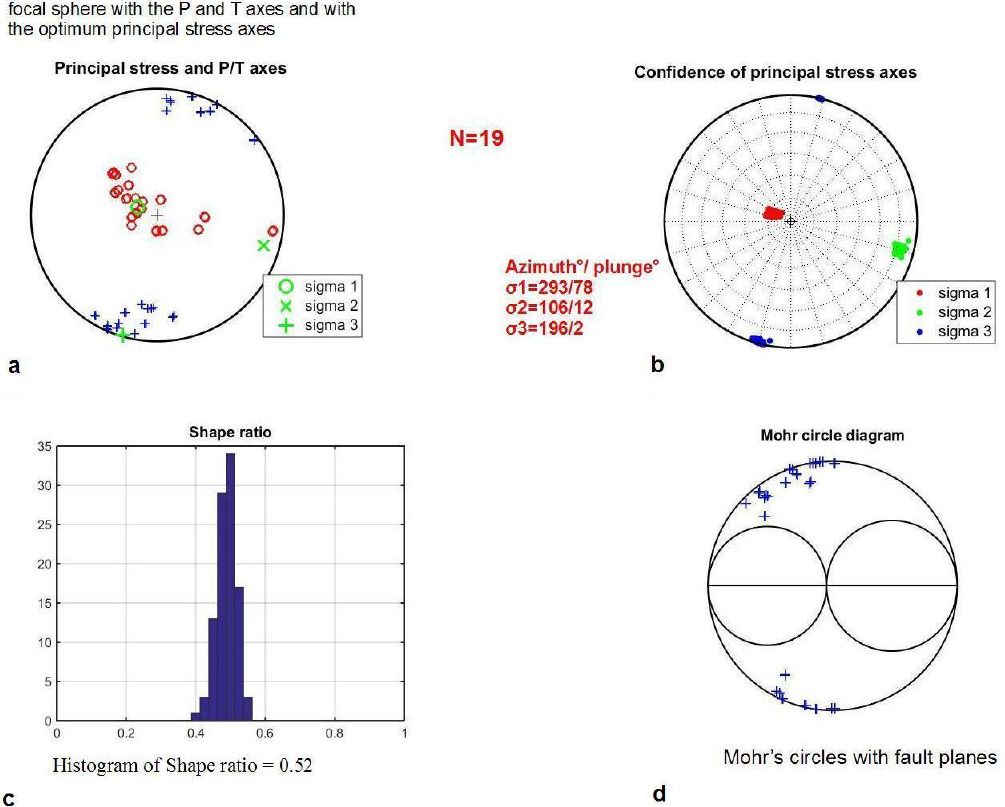
Figure 8. Results of stress analysis: ( a ) plot of focal sphere with the P and T axes and with the optimum principal stress axes (azimuth and plunge); ( b ) plot with confidence limits of the principal stress directions ( c ) histogram of the shape ratio R ( σ 1 - σ 2 / σ 1 - σ 3 ; ( d ) Mohr’s circles with activated conjugate fault planes. Stress axes from inversion are shown in lower-hemisphere projection, uncertainty distribution calculated against 1000 realizations of noise. The P axes are marked by the red circles and T axes by the blue crosses. Red: maximum compressive stress, σ 1 . Green: intermediate principal stress, σ σ 2 . Blue: minimum compressive stress, 3